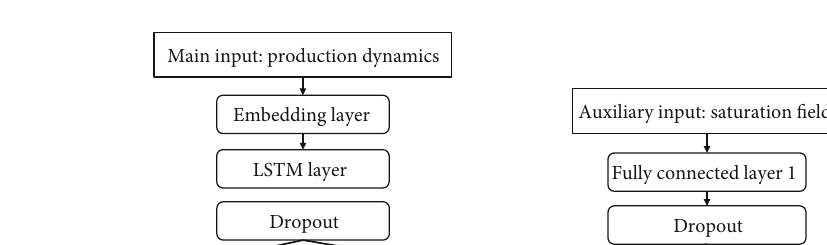
Figure 2: LSTM hidden layer neural unit.